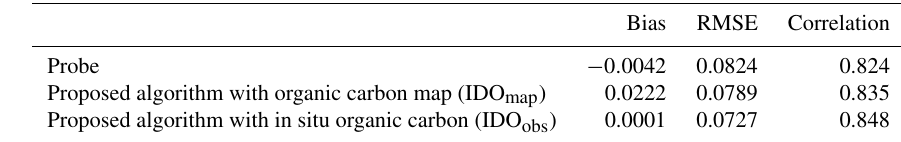
Table 3. Validation of soil moisture obtained from Probe (Probe SM), organic-rich mineral soil based on the SoilGrid250m organic carbon map (IDOmap), and SMAPVEX12 OC in situ observation (IDO obs ).